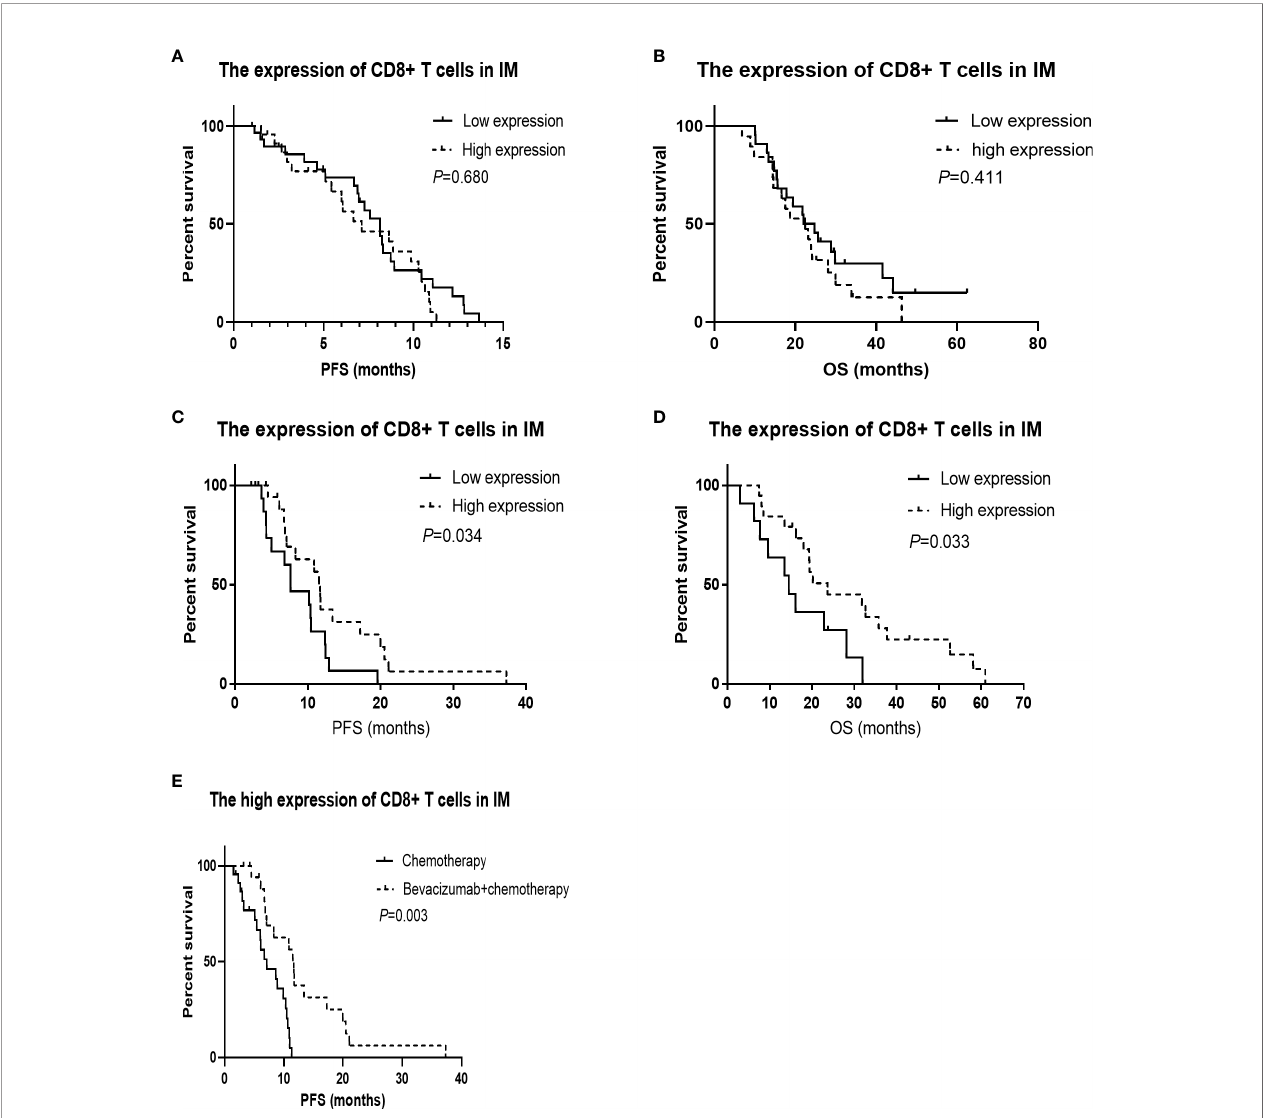
FIGURE 2 | Kaplan-Meier survival curves according to the tumor in fi ltrated immune cells. CD8+ in invasive margin (IM) predicts the effect of bevacizumab plus chemotherapy, and patients with high CD8+ in IM have longer overall survival (OS) treated with bevacizumab plus chemotherapy. (A) The PFS was not signi fi cantly worse in the low CD8+ T cells in IM group treated with chemotherapy ( P = 0.680). (B) The OS was not signi fi cantly worse in the low CD8+ T cells in IM group treated with chemotherapy ( P = 0.411). (C) The progression-free survival (PFS) was signi fi cantly worse in the low CD8+ T cells in IM group treated with chemotherapy combined with bevacizumab ( P = 0.034). (D) The OS was signi fi cantly worse in the low CD8+ T cells in IM group treated with chemotherapy combined with bevacizumab ( P = 0.033). (E) For the patients with high CD8+ T cells in IM group, The PFS was signi fi cantly better in the arm of chemotherapy combined with bevacizumab than that of chemotherapy alone ( P =